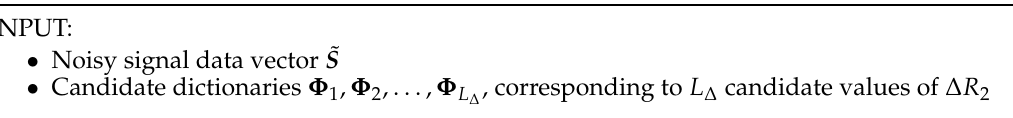
Table 1. The pruned orthogonal matching pursuit (POMP) algorithm ( M =